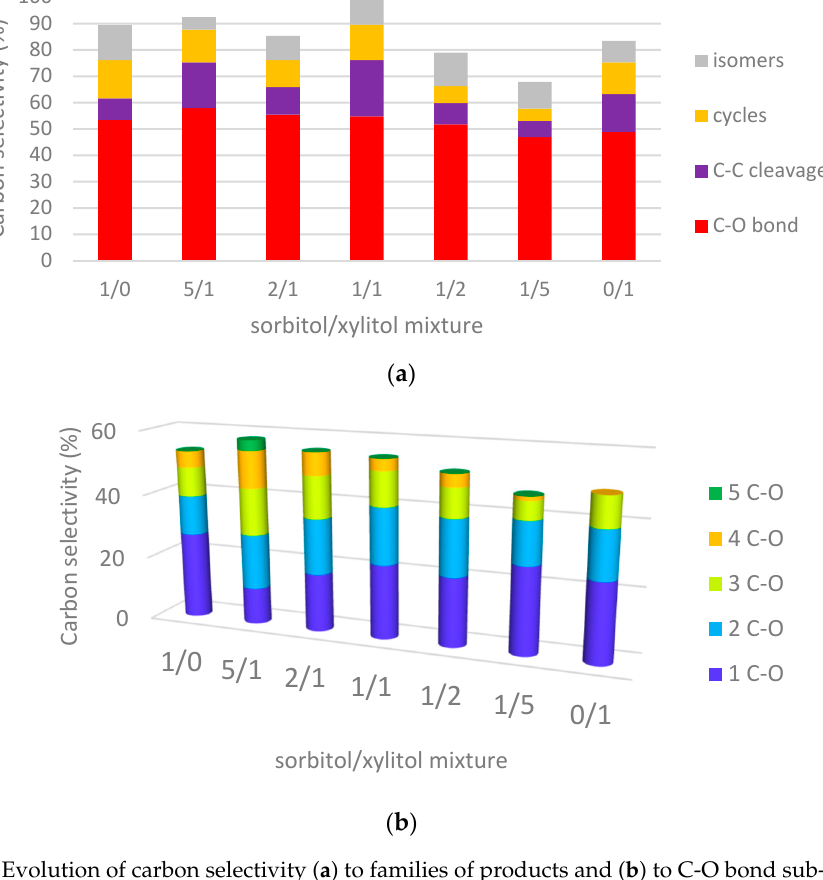
Figure 5. Evolution of carbon selectivity ( a ) to families of products and ( b ) to C-O bond sub-families versus sorbitol/xylitol mixtures during hydrogenolysis of polyols over ReO x -Rh/ZrO 2 at ca. 80% conversion, 200 °C under 80 bar H 2 , substrate/nRh ~ 200–300 .